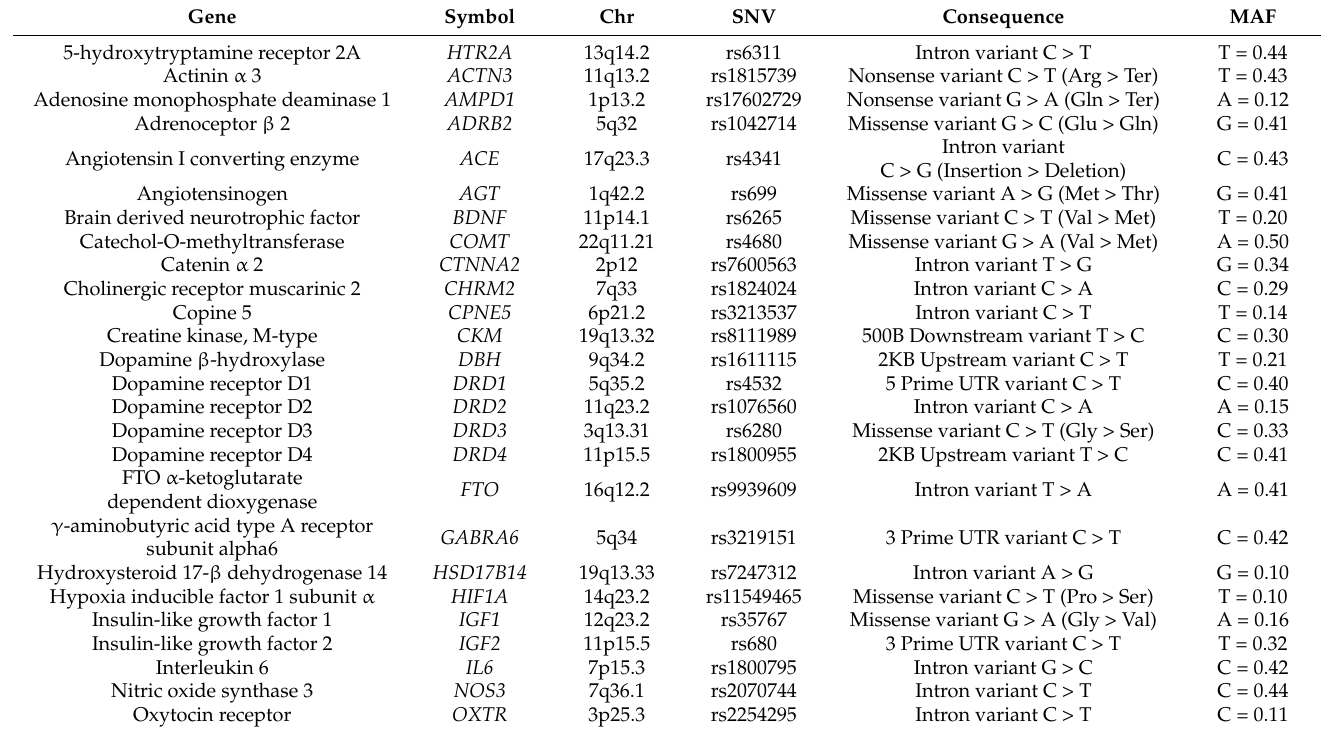
Table 1. Gene and single nucleotide variant (SNV)